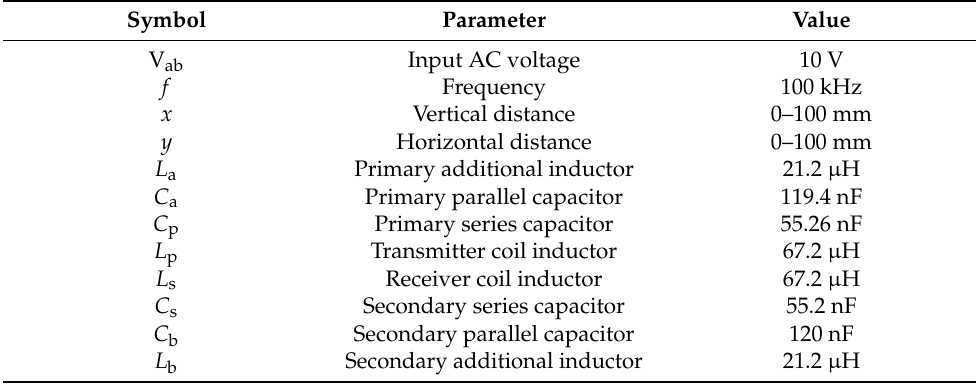
Figure 11. Experimental prototype.